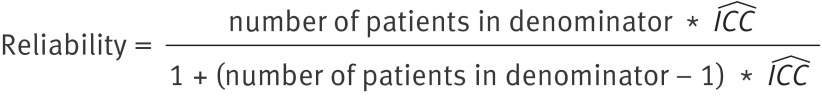
Fig 3 Spearman-Brown prophecy formula